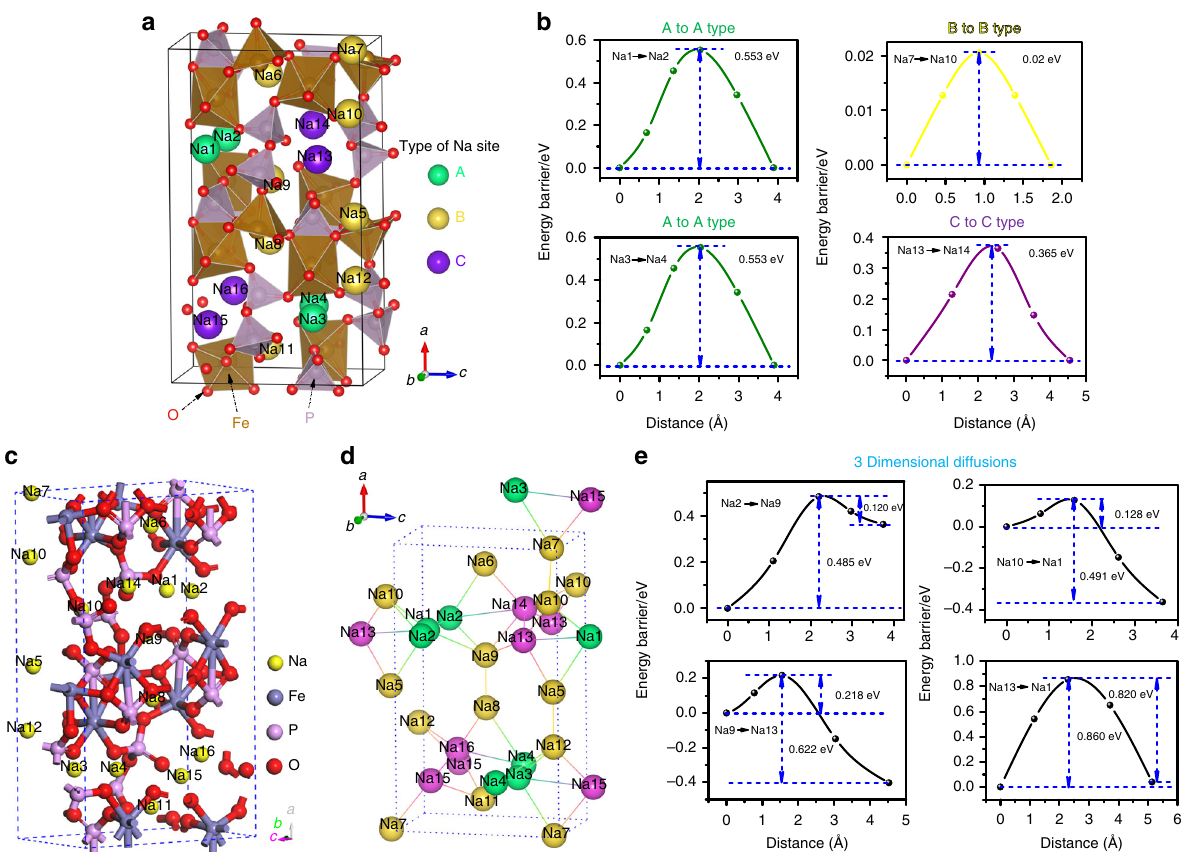
Fig. 5 Crystal structure, Na + ion diffusion paths, different types of Na + ions in a single unit, and corresponding migration energy barriers. a , c , d Various images of the crystal structure of Na 4 Fe 3 (PO 4 ) 2 (P 2 O 7 ) material with three different types of Na + ions. b The migration energy barriers within the same Na + ion groups. e The migration energy barriers between different Na + ion groups (equivalent to three-dimensional diffusion